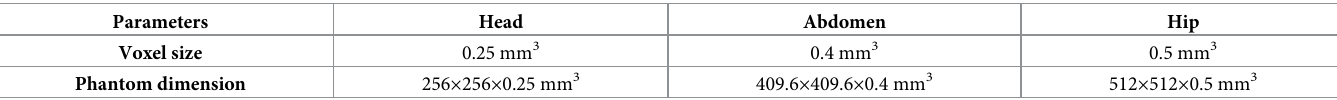
Table 2. The parameters for various regions of the XCAT phantom.